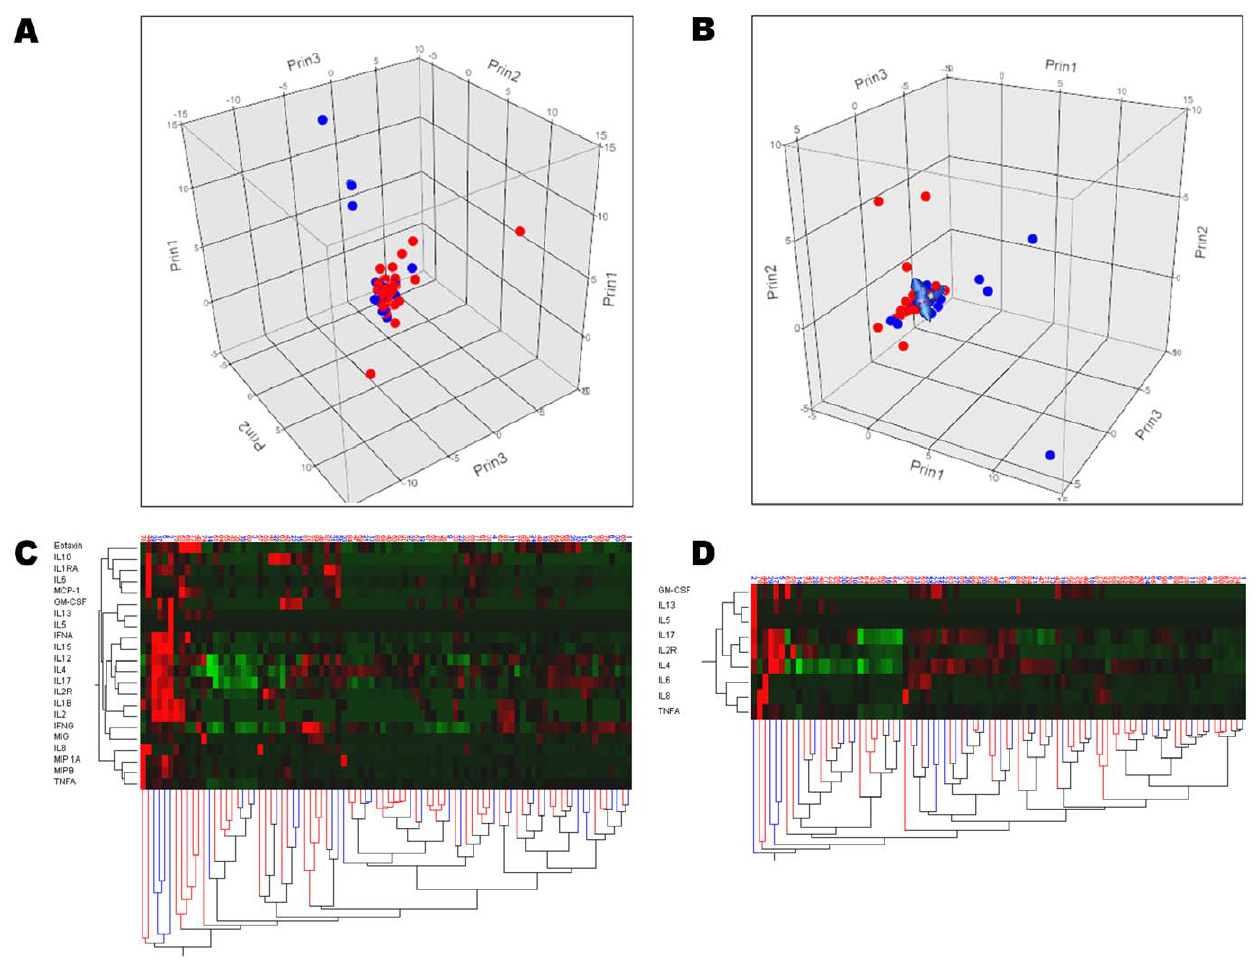
Figure 4. Principal component analysis and clustering of cytokine profiles in febrile patients with (n=59) and without (n=30) bacterial infection. Febrile patients with (red dots) and without (blue dots) bacterial infection are represented according to the first three components computed using principal component analysis of either all 22 cytokines (panel A), or a more limited profile using only GM-CSF, IL-13, IL- 4, IL-5, IL-6, sIL-2R, IL-17, IL-8 and TNF- a (panel B). Hierarchical cluster analysis using all 22 cytokines measured (panel C) and the more limited profile (panel D) are also presented. The dendrogram at the bottom of panels C & D shows the clustering of febrile patients with (red lines) and without (blues lines) bacterial infection, according to the cytokine profile selected (dendrodram at the left). The color map at the center indicates the cytokine levels for each patient (brightest green is lowest level and brightest red is highest level measured). Altogether, these analyses show that febrile patients with bacterial infection cannot be distinguished from those without.